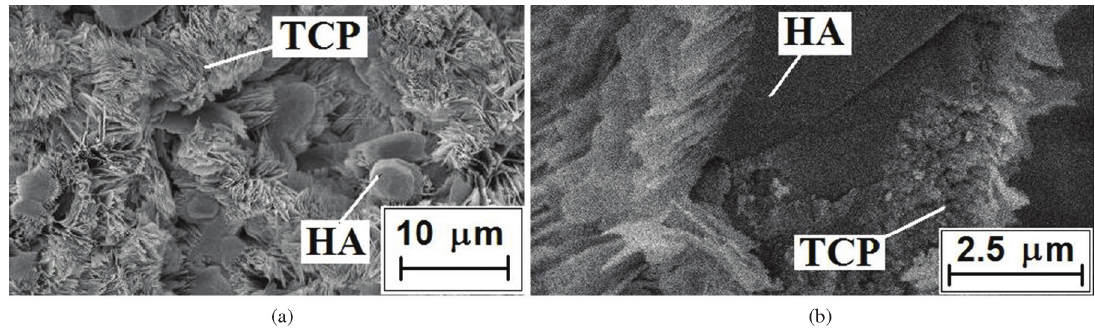
Figure 6. HA/TCP scaffold after 14 days in contact with Sörensen buffer solution. (a) External surface; (b) Fracture surface where, TCP: alpha-tricalcium phosphate; and HA: hydroxyapatite.